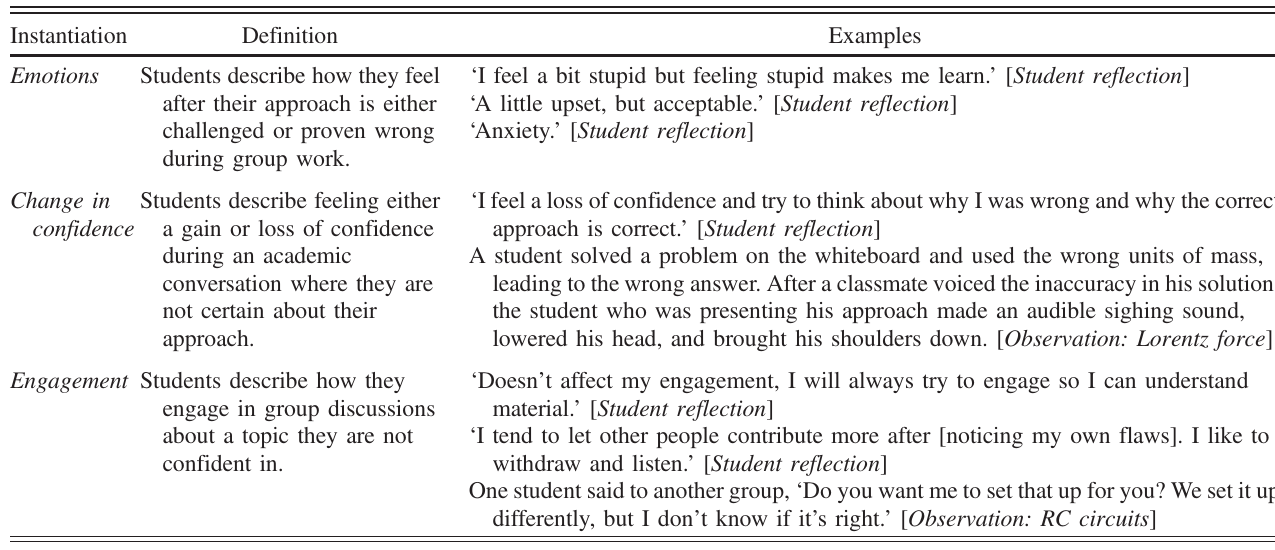
TABLE IV. Definitions and examples of instantiations related to appropriate discomfort with